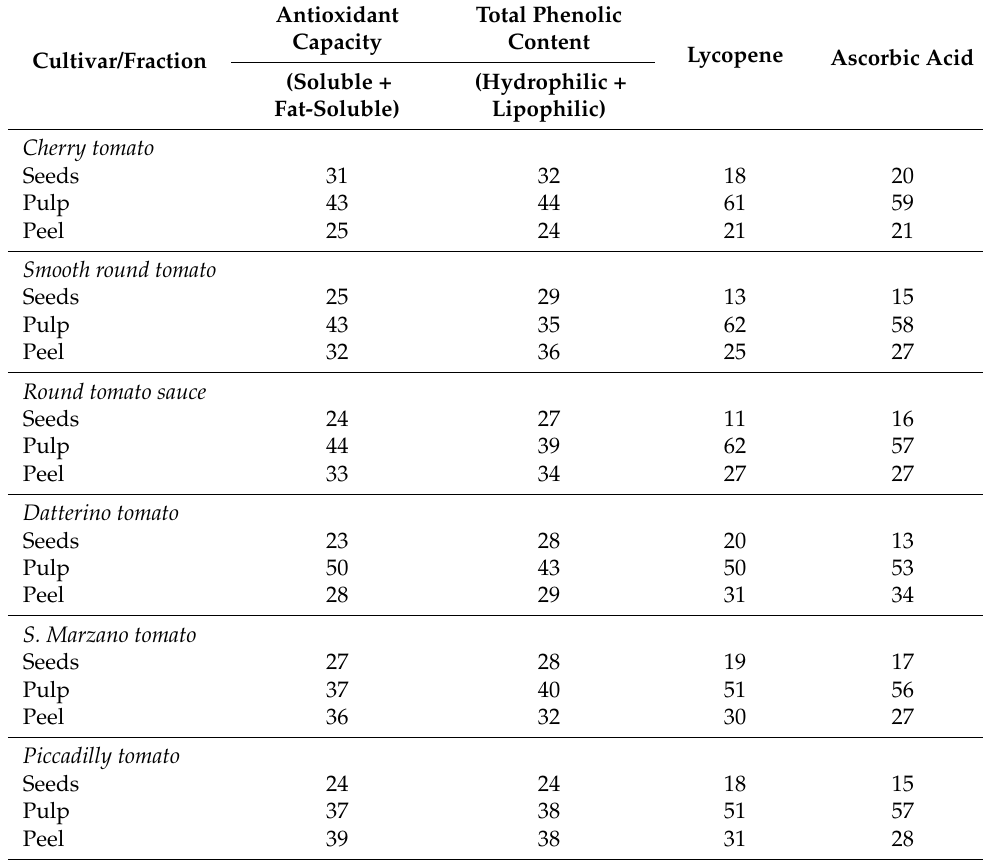
Table 5. Percentage contributions of the seeds, pulp, and peel fractions to the total antioxidant